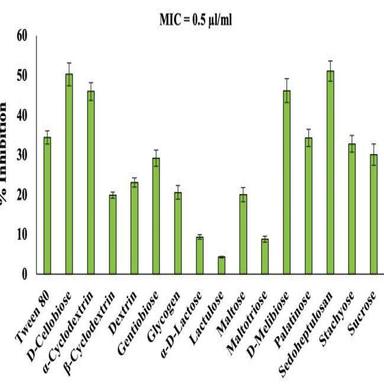
A. Percent inhibition on carbon sources metabolism by CIM (a) Monosaccharide and (d) Disaccharide carbon sources. B. In-silico and molecular mechanism of action of CIM against AFB1 biosynthetic genes (a) Interaction of receptors and ligand (b) Binding energy of interaction, gene expression analysis of (c) ver-1 by qRT-PCR and (d) Schematic representation of the anti-aflatoxigenic activity of CIM at the molecular level.